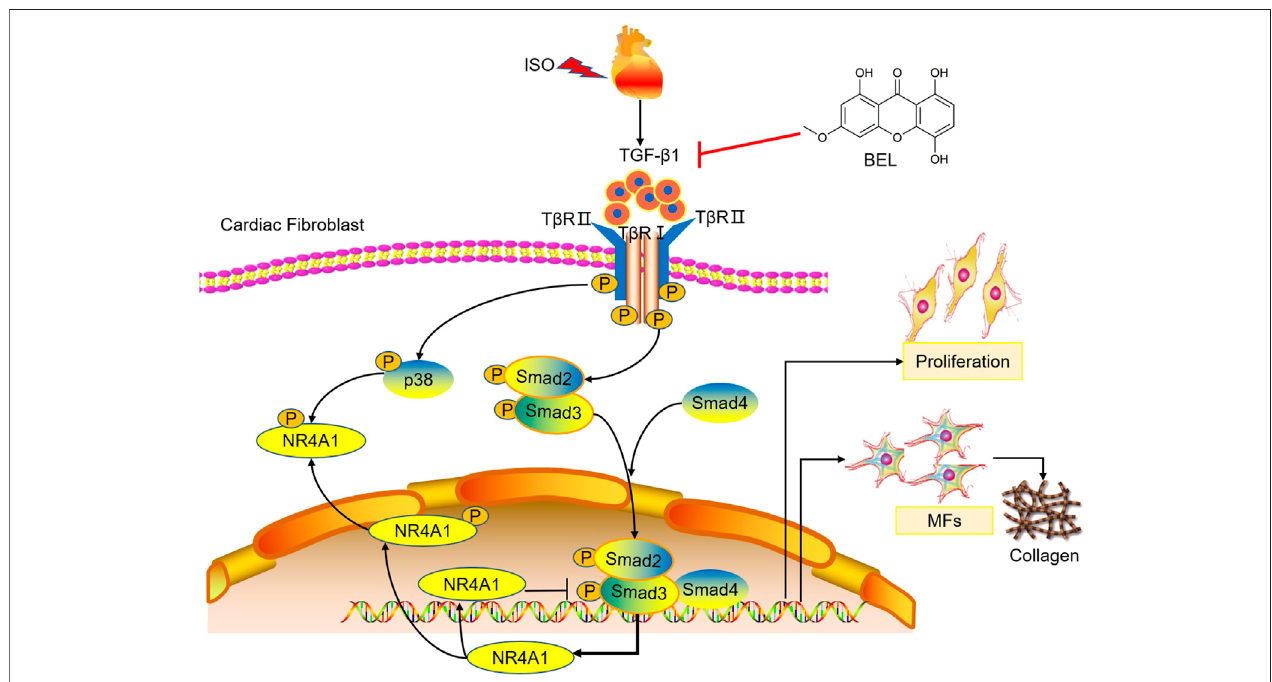
FIGURE12| The proposed anti fi brotic mechanism ofBEL. BELdownregulates thephosphorylation ofT β RIand T β RII,suppresses Smads2 and 4expression and the phosphorylation and activation of Smads2 and 3 in CFs. Furthermore, BEL inhibits p38 phosphorylation and impedes NR4A1 cytoplasmic localization, which restores the inhibitory effect of NR4A1 to TGF- β 1-pro fi brotic signaling. These inhibitory effects further caused a decrease in the expression of α -SMA, collagen I, and collagen III, thereby preventing proliferation and activation of CFs to alleviate myocardial fi